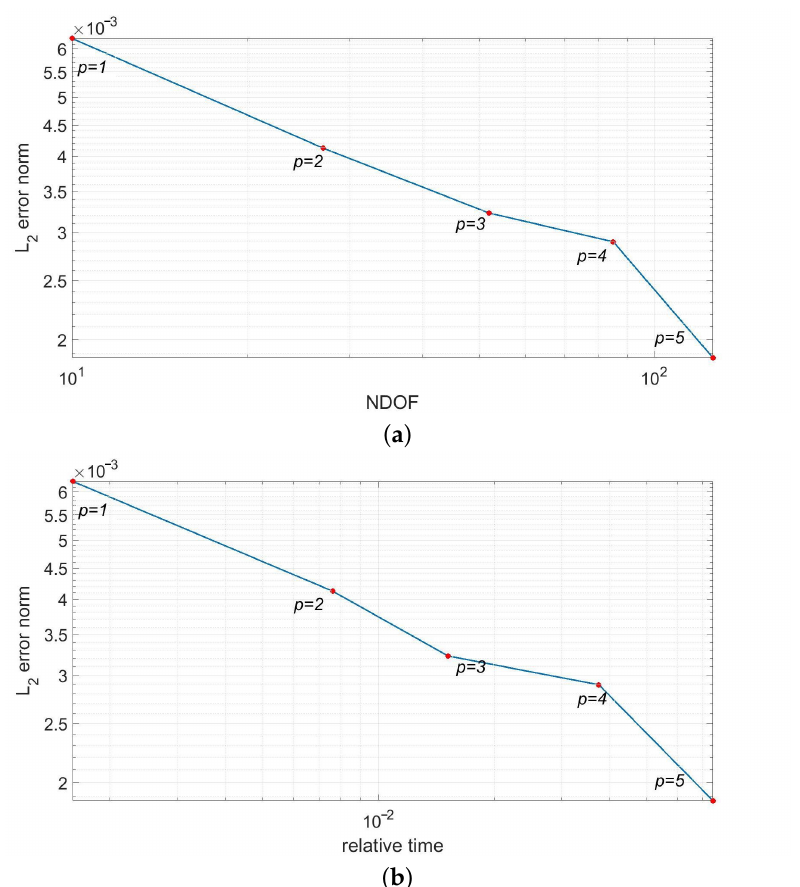
Figure 11. Convergence test for the increasing approximation orders at the macroscale (logarithmic scale) w.r.t. ( a ) number of degrees of freedom and ( b ) relative time (the ratio of the computational time used for the upscaled and reference